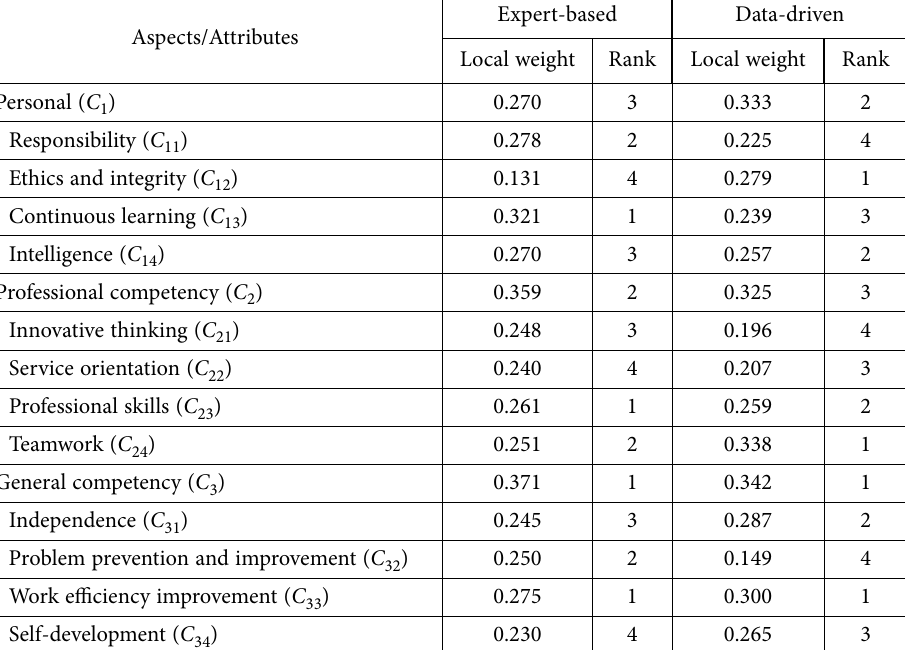
Table 11. Comparison between the domain-knowledge and the data-driven knowledge models